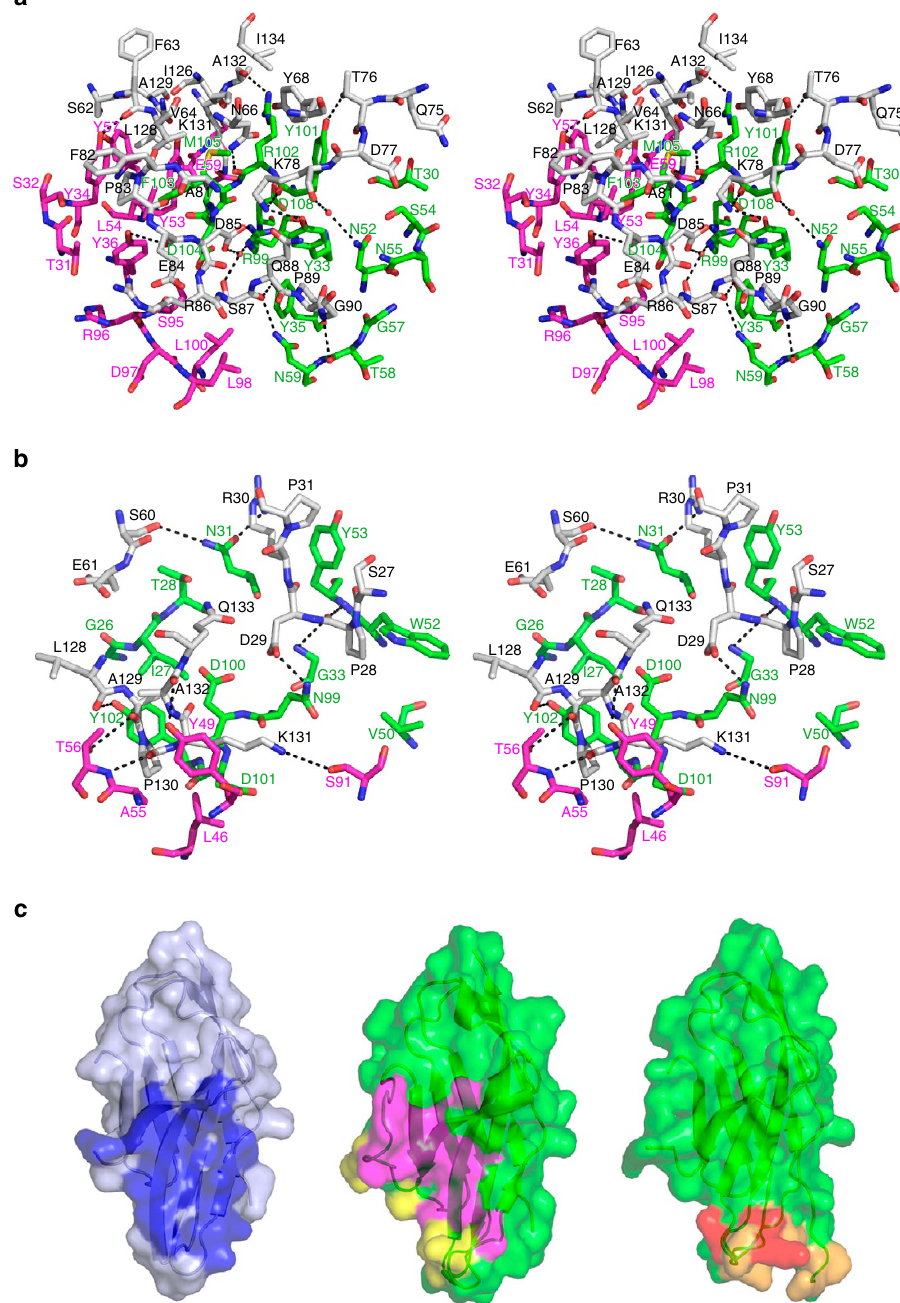
Figure 2 | Interactions between PD-1 and anti-PD-1 drugs. ( a ) Stereoview of the detailed PD-1/pembrolizumab interface. ( b ) Stereoview of the detailed PD-1/nivolumab interface. In a and b , the carbon atoms of PD-1 and heavy and light chain of anti-PD-1 are coloured grey, green, and purple, respectively. Hydrogen bonds and a salt bridge are indicated with dashed lines. ( c ) Surface representations of the PD-1 molecules in the complex structures of PD-1/PD-L1 (left), PD-1/pembrolizumab (centre) and PD-1/nivolumab (right). The surface of PD-1 in PD-1/PD-L1 is coloured pale blue and the PD-L1 binding site on the surface of PD-1 is coloured blue. The surfaces of PD-1 in PD-1/anti-PD-1 are coloured green. The epitope regions for the heavy and light chains of pembrolizumab are coloured purple and yellow, respectively. The epitope regions for the heavy and light chains of nivolumab are colored orange and red,